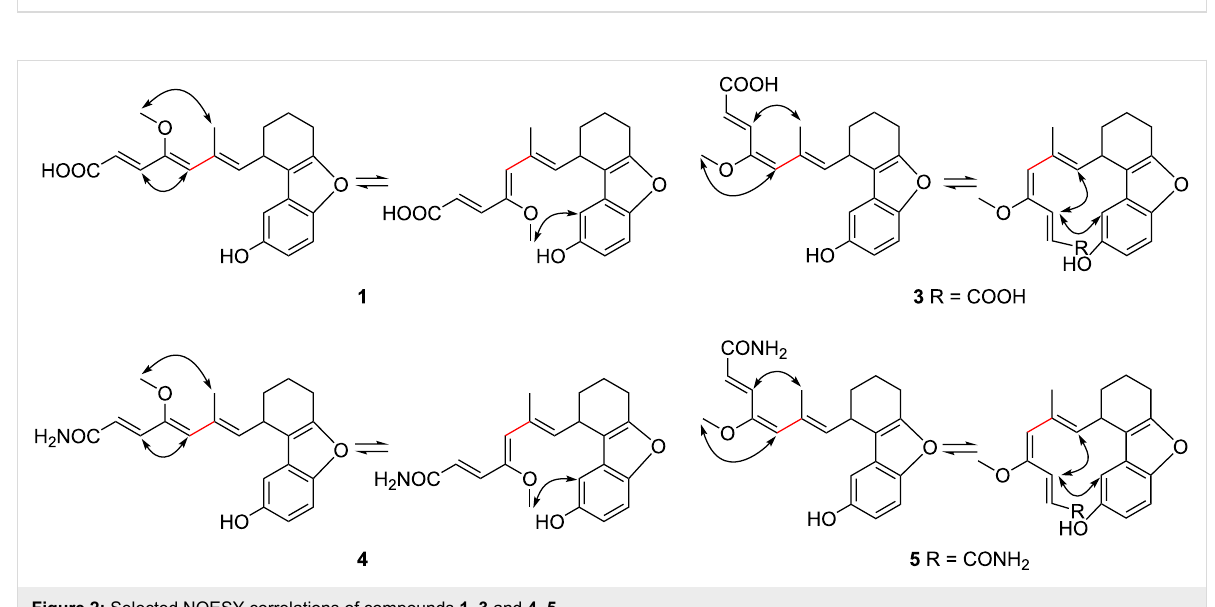
bacteria such as Bacillus subtilis strain ATCC 11060 (diame- ters of inhibitory zones 11.5, 12.3 and 14.2 mm, respectively) at 30 μ g/disc, and modest activity against fungi such as Fusarium